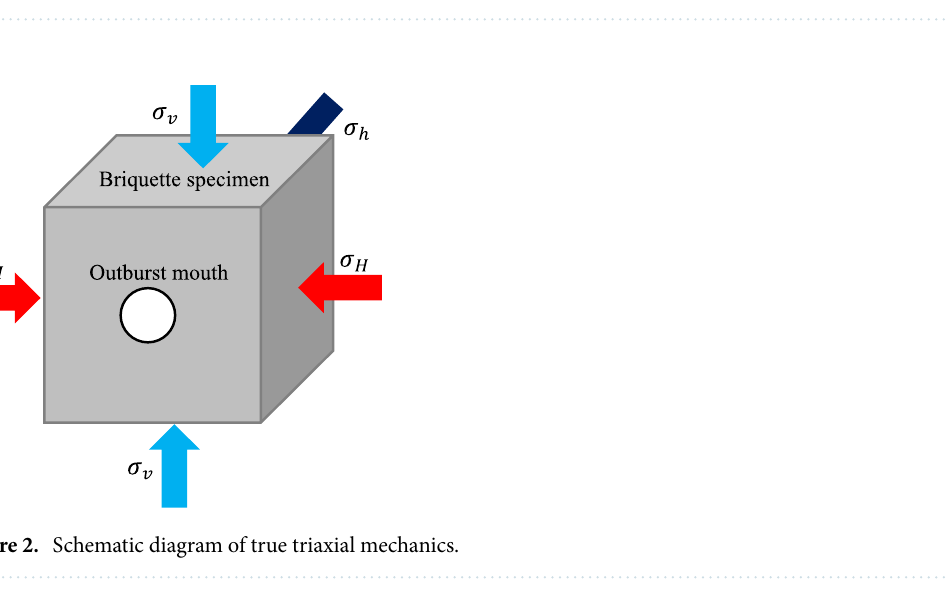
Figure 1. True triaxial coal and gas outburst physical simulation test system: 1—console; 2—hydraulic station; 3—data collector; 4—vacuum pump; 5—gas cylinder; 6—valve; 7—gas pressure sensor; 8—true triaxial tester; 9—acoustic emission; 10—acoustic emission data acquisition system.